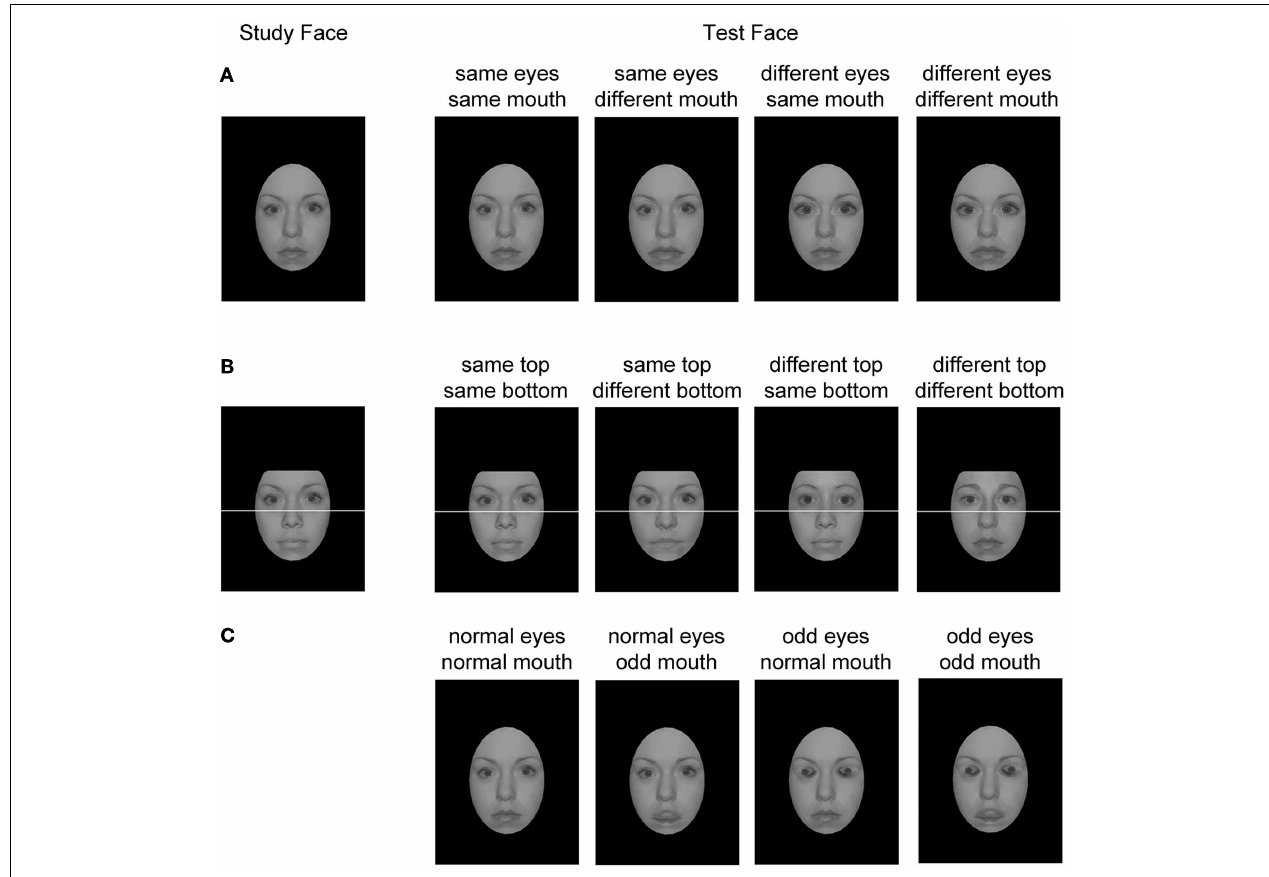
FIGURE 2 | Examples of stimuli from each of the four conditions in each of the three experiments. (A) Feature SizeTask; (B) Feature IdentityTask; (C) Feature OrientationTask.